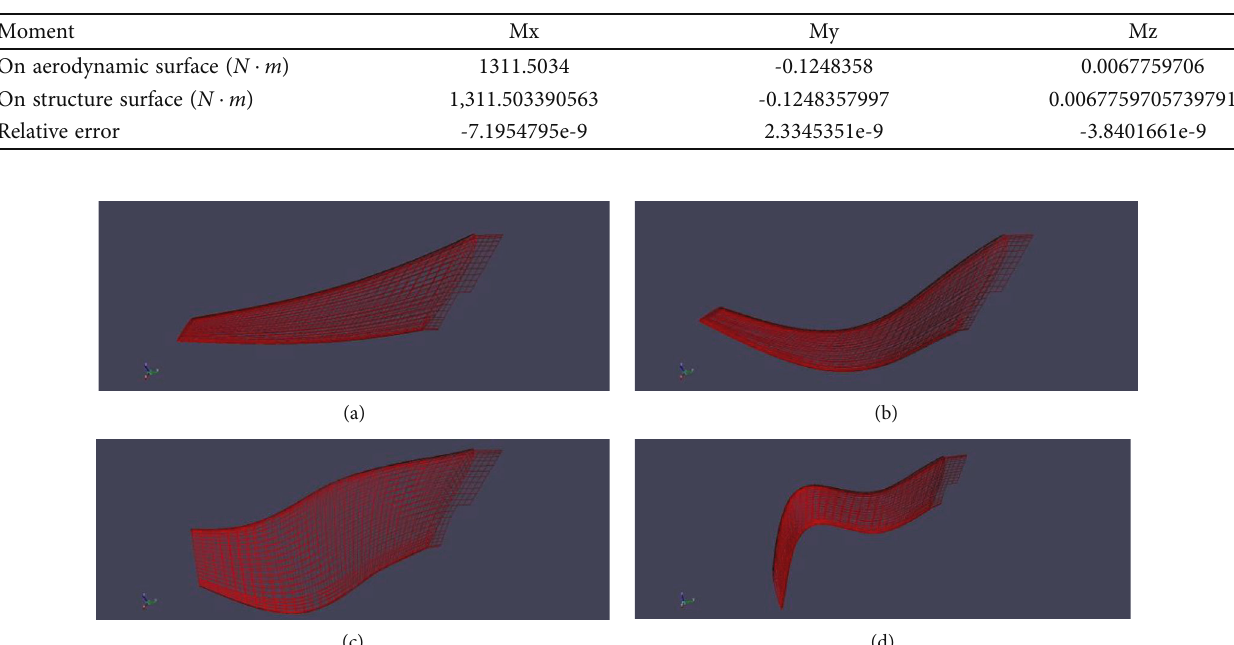
Figure 10: The structure ’ s mode shapes: (a) the fi rst order mode; (b) the second order mode; (c) the third order mode; (d) the fourth order mode.